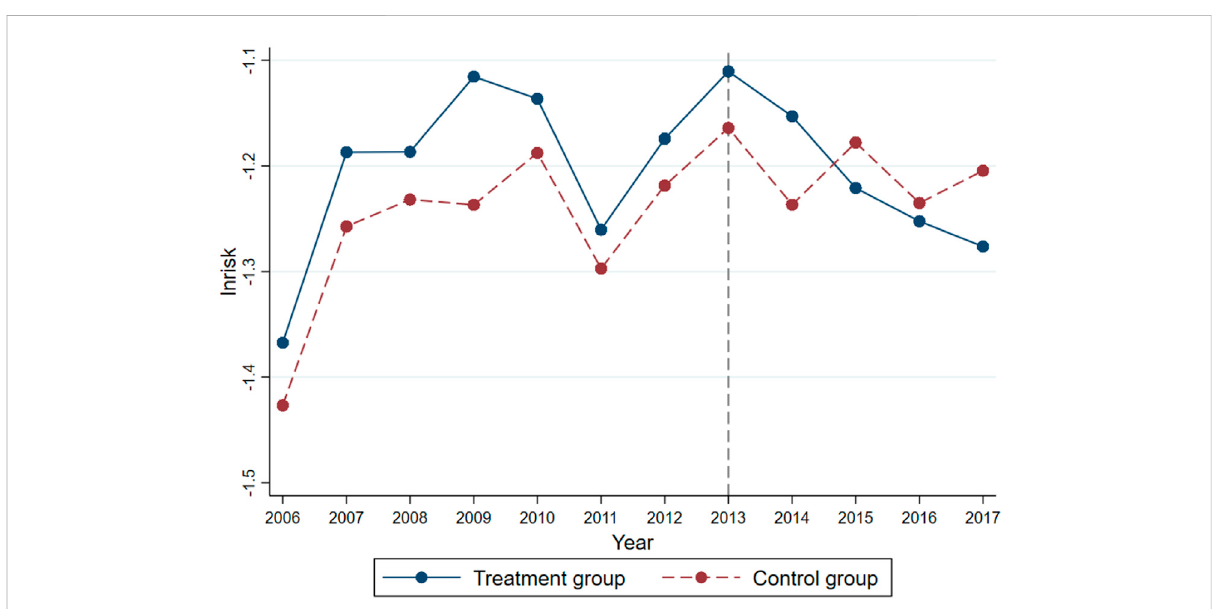
FIGURE 1 Comparison of annual means of ecological risk between the treatment and control